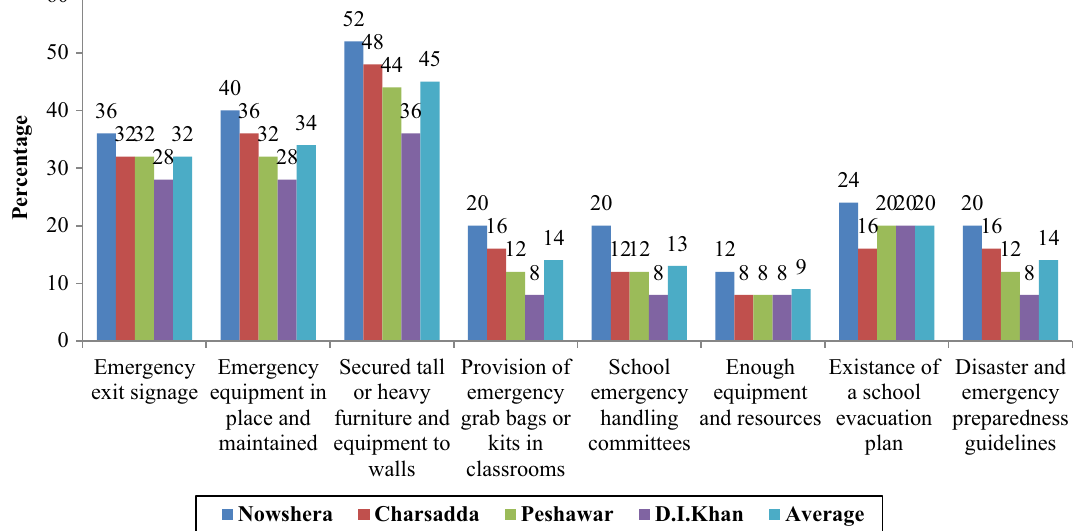
Fig. 4 Preparation measures adopted and in place in Khyber Pakhtunkhwa’s schools,